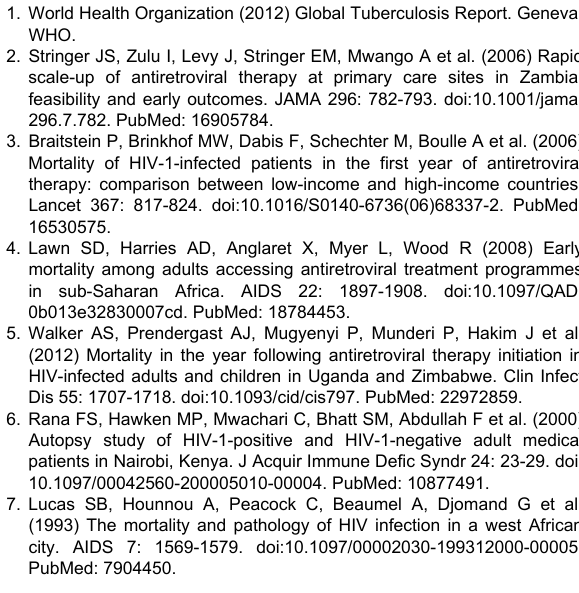
Table S3. Timing of TB treatment in relation to cART initiation, by study.